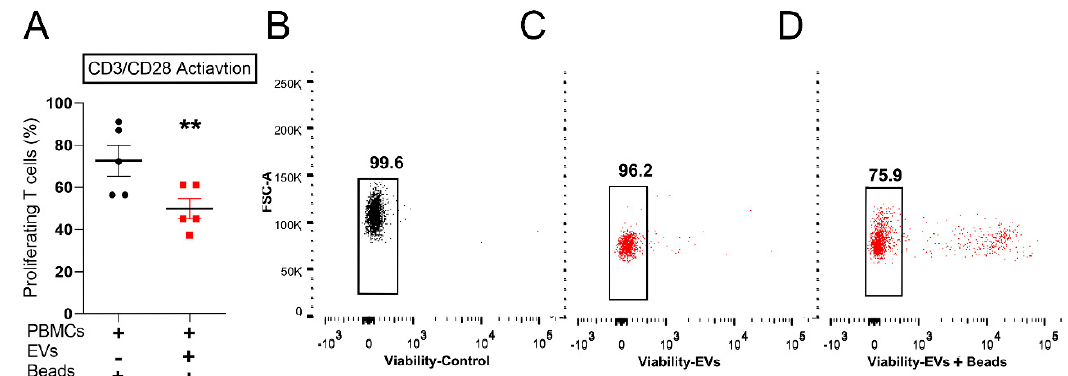
Figure 6. USCs EVs effect on T cells in response to anti–CD3/CD28 stimulation; ( A ) Effect of the EVs on the proliferation of T cells in the presence of anti–CD3/CD28–bead stimulation showing significant suppression of the T cell proliferation (represented by % proliferating cells, n = 5). Values are presented as mean ± SEM, and p -values were determined by paired t –test analysis. ** p < 0.01. ( B – D ) A representative sample of the viability assay of CD3 + (T cell) population where ( B ) control T cells viability, ( C ) viability in re- sponse to EVs co-culture. ( D ) Viability in response to EV co-culture in the presence of anti–CD3/CD28 beads. Note the decrease in the viable population in the activated T cells co-cultured with EVs.